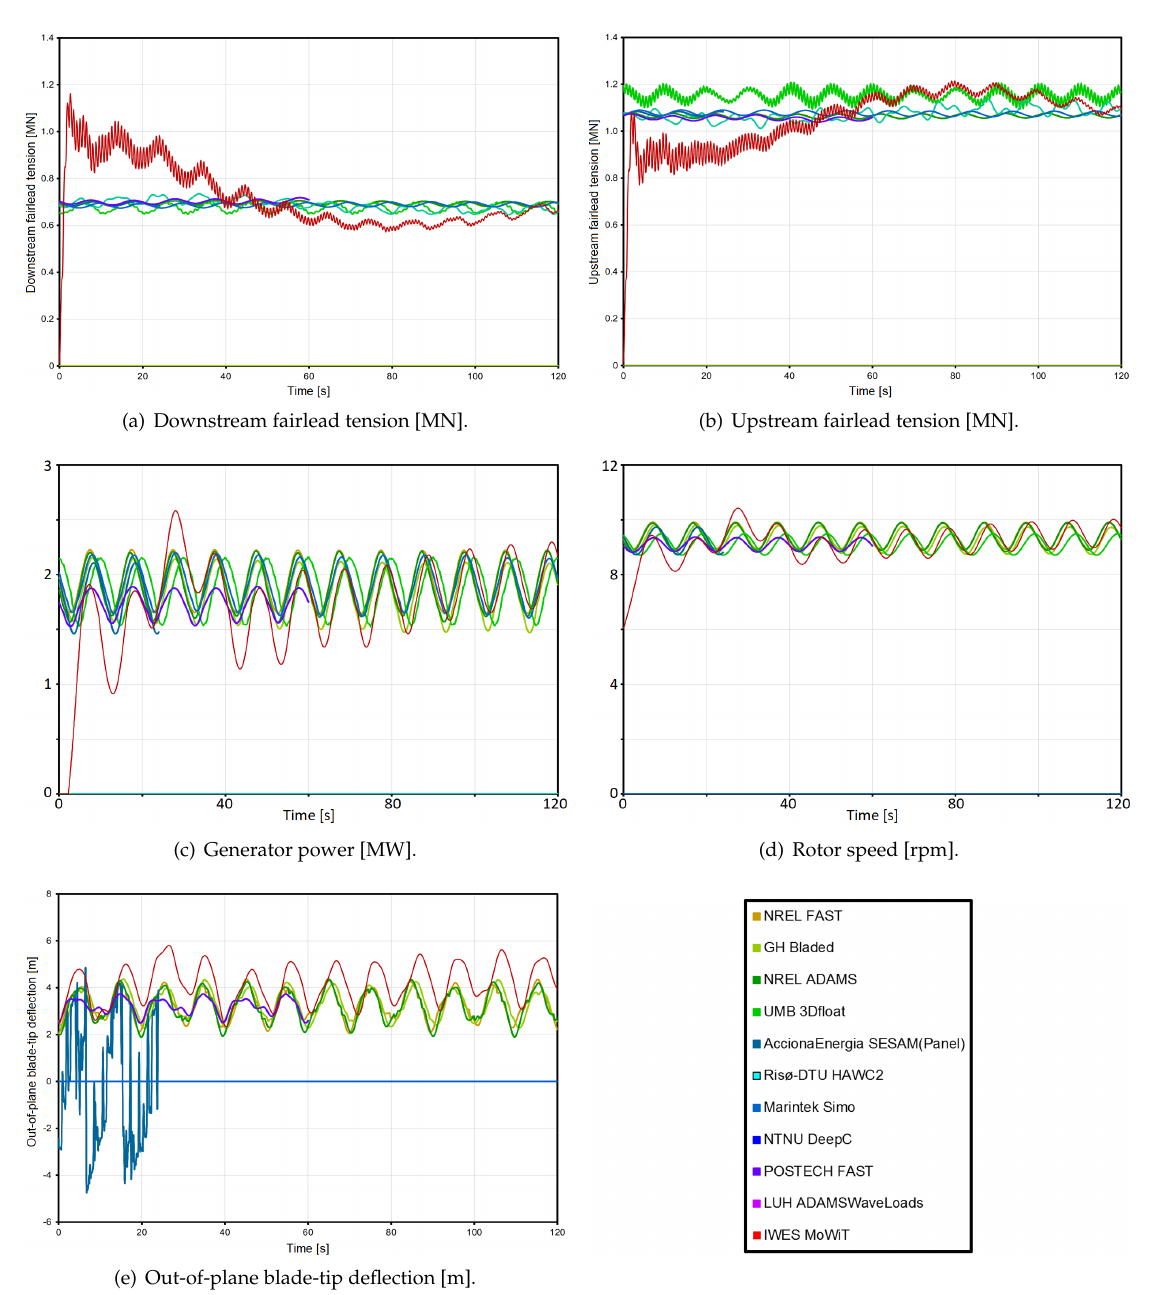
Figure 15. Aero-hydro-servo-elastic time series with regular waves from LC 5.1, part